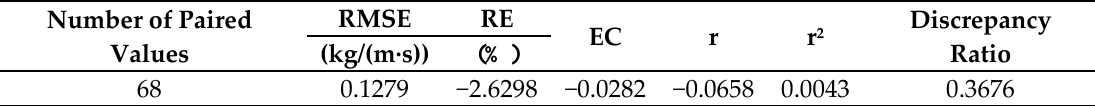
Table 2. Statistical criteria values of Nest os River (optimization).